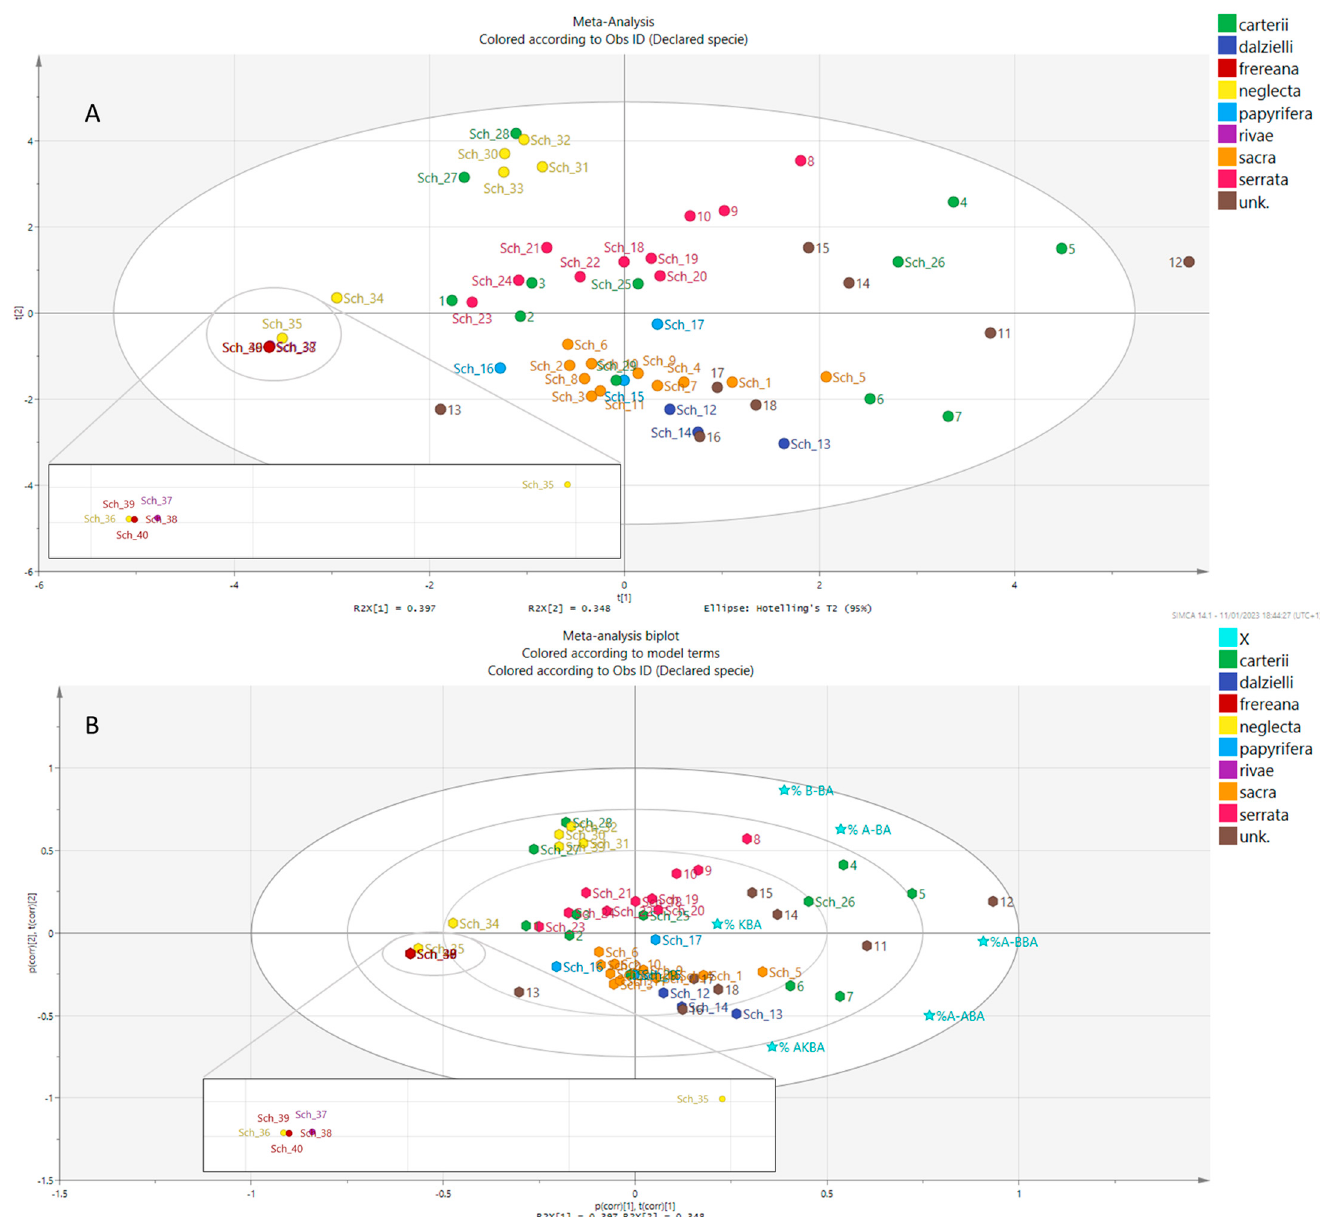
Figure 2. ( A ) PCA score plot for the analysis of the samples in the meta-multivariate study. Each circular dot represents a sample, and its color represents the species, as reported in the legend. ( B ) Biplot of the PCA model for the set of samples in the meta-multivariate study. Each circular orange dot represents a sample, while each green dot represents the loading of each variable. To better observe the overlapped regions, a magnification of the overlapped area is proposed for both plots.